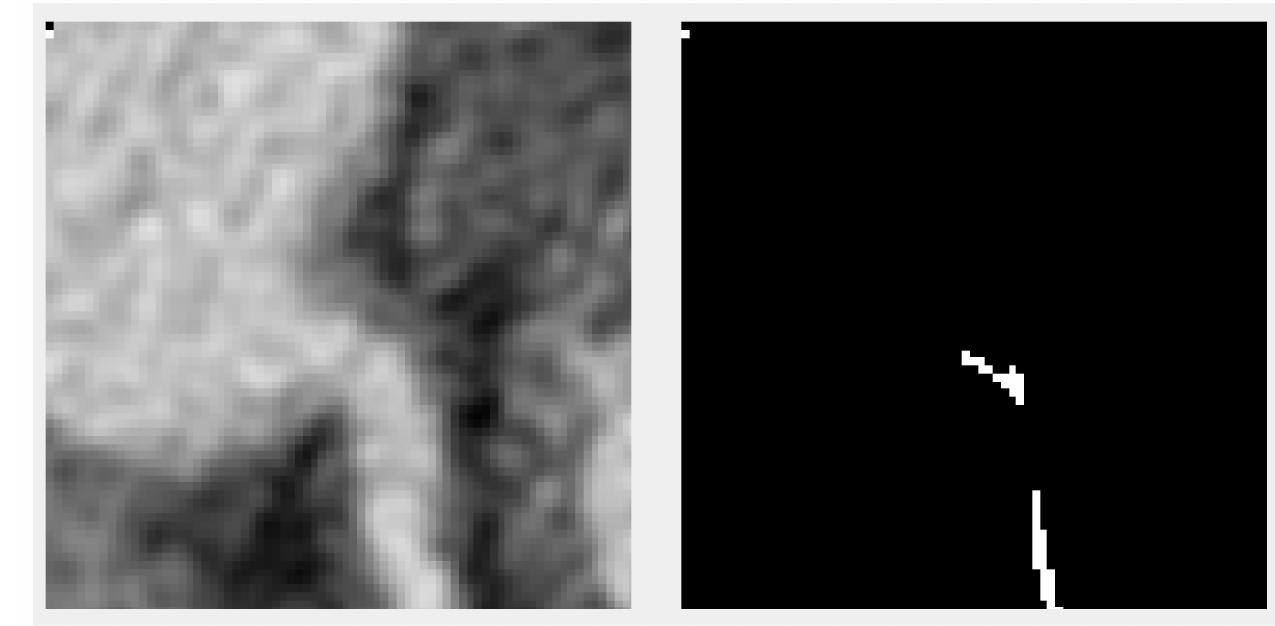
Figure 3. A 2D slice of an augmented patch with ground truth next to